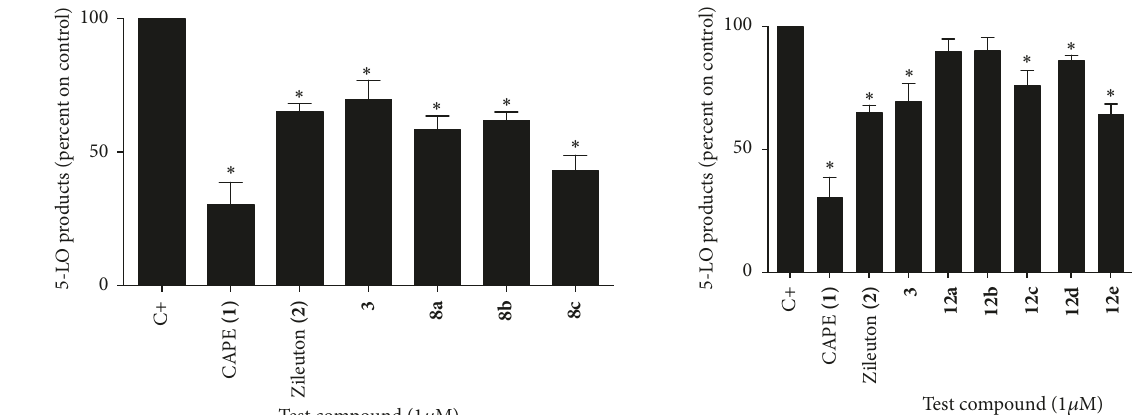
Figure3:Inhibitionof5-LOproductssynthesisbyanalogs( 8a–c )in whole HEK293 cells. Values are the means ± SEM of three indepen- dent experiments, each performed in quadruplicate; ∗ different from control (diluent) as determined by one-way ANOVA with Dunnett’s multiple comparison test ( 𝑝 < 0.05 ).